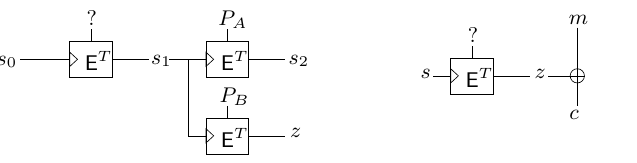
Figure 7: (Left) Illustration on the 2- up assumption; (Right) Basic message